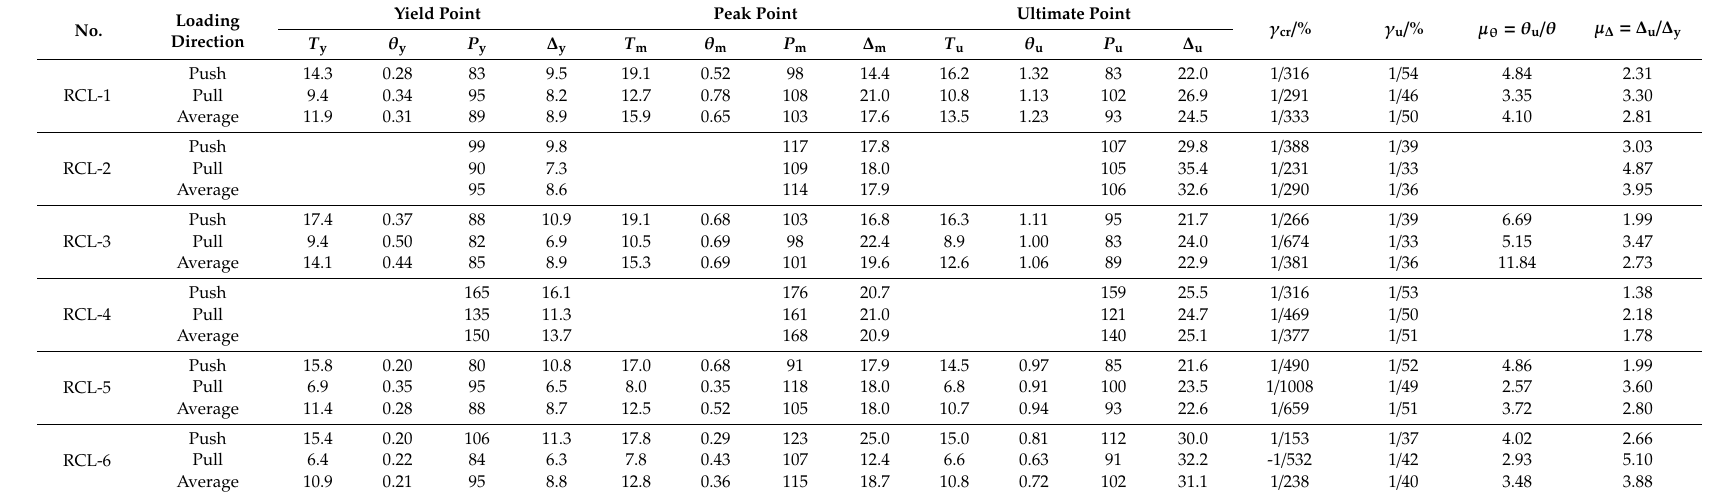
Table 2. Characteristics point of